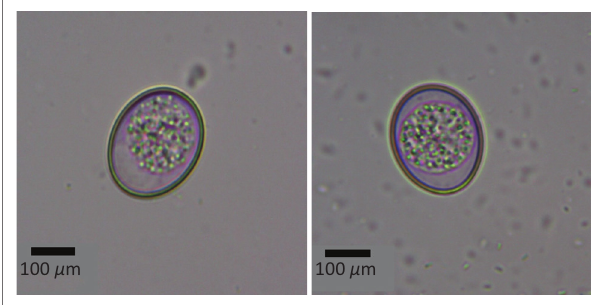
100 μ m FIGURE 1: Images of unsporulated Eimeria oocysts detected in faecal samples from infected farms.